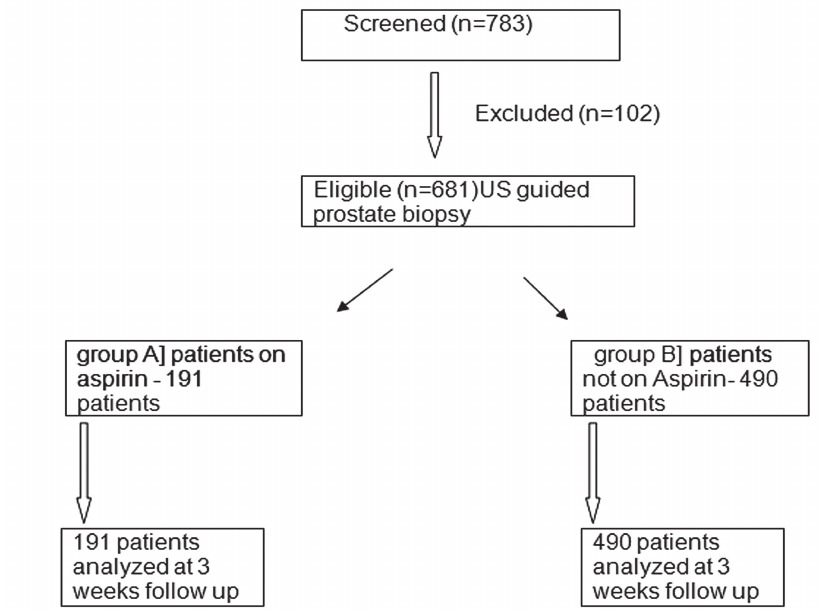
figure 1 - Allocation and dispersion of